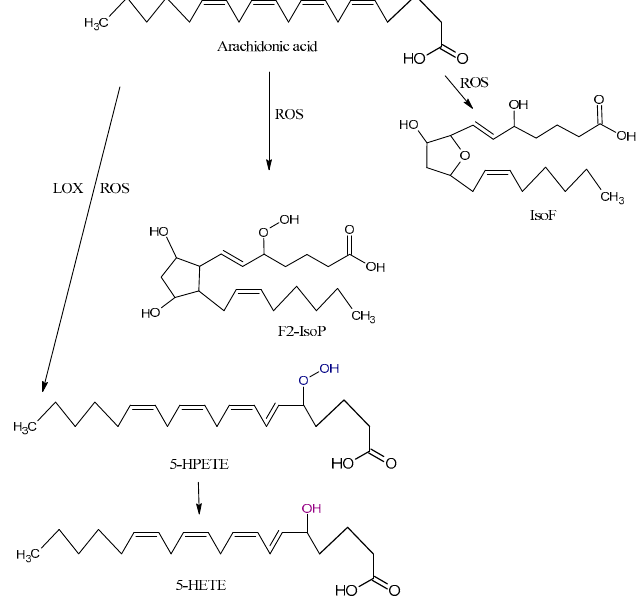
Figure 3. Three types of oxidation products of arachidonic acid (AA): isofurans (IsoFs), isoprostanes (IsoP), hydroperoxyeicosatetraenoic acid (HPETE), hydroxyeicosatetraenoic acid (HETE), ROS, and LOX.